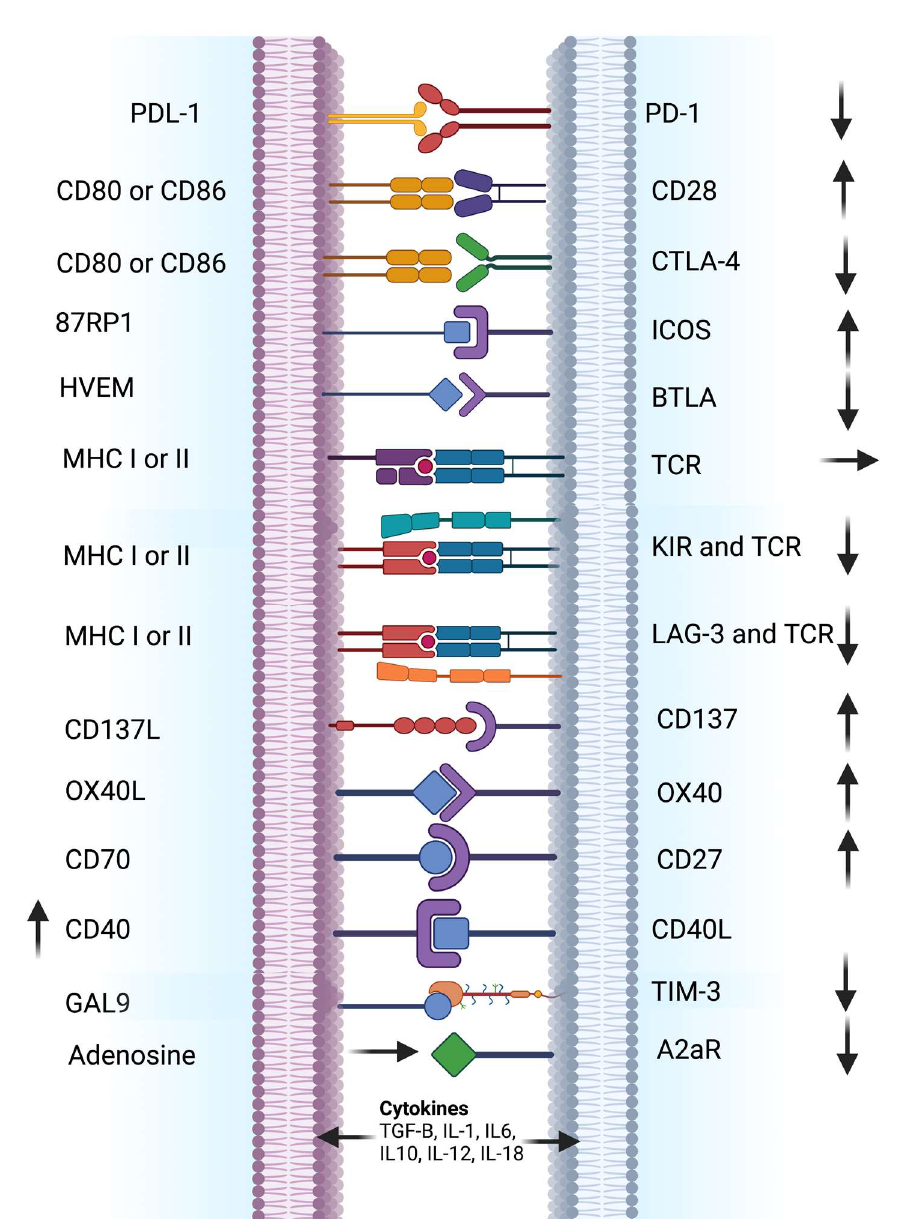
Figure 1. Immune cell and cancer cell or antigen-presenting cell receptor-ligand interactions involved in immune checkpoint modulation. The figure illustrates an overview of implicated receptor-ligand interactions and their general effects on the immune response. Several immune cells, such as CD8 + T cells, CD4 + T cells, NK cells, and Tregs, express specific receptors, which are recognized and bound by their specific ligands present on the surface of various cancer cells or antigen-presenting cells. The illustration also depicts examples of different receptors and ligands involved in ICI modulation, along with generalized stimulatory ( ↑ ) or inhibitory ( ↓ ) effects. ICIs block various inhibitory receptor-ligand interactions leading to the activation of immune cells, which leads to tumor regression. ICI therapies, including anti-PD-1/PD-L1 and anti-CTLA-4, have shown clinical efficacy for many cancers, which provided opportunities for developing alternative ICIs (e.g., anti-LAG-3, anti-TIM-3, and anti-NKG2). Adapted from ref. [3,34]. Created with BioRender.com (accessed on 18 November 2022). Definitions of abbreviations are found in the abbreviations list at the end of the